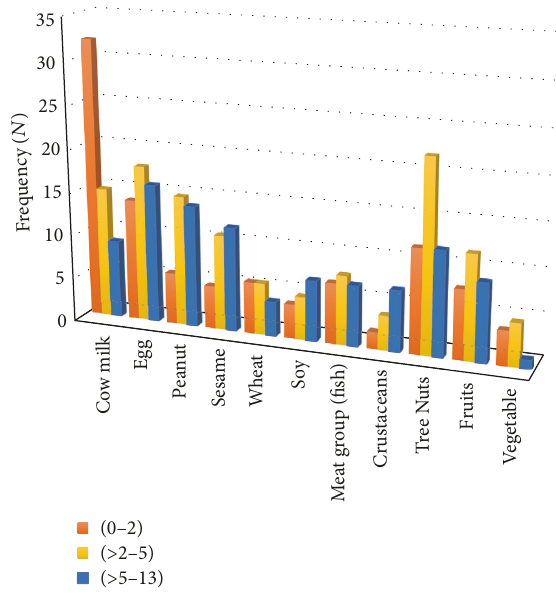
Figure 2: Common food allergens reported in children with confirmed food allergy, stratified by age group, in years ( 𝑛 = 100 ). Note: some cases were reported to have more than one type of food allergen ( 𝑛 = 33 ).